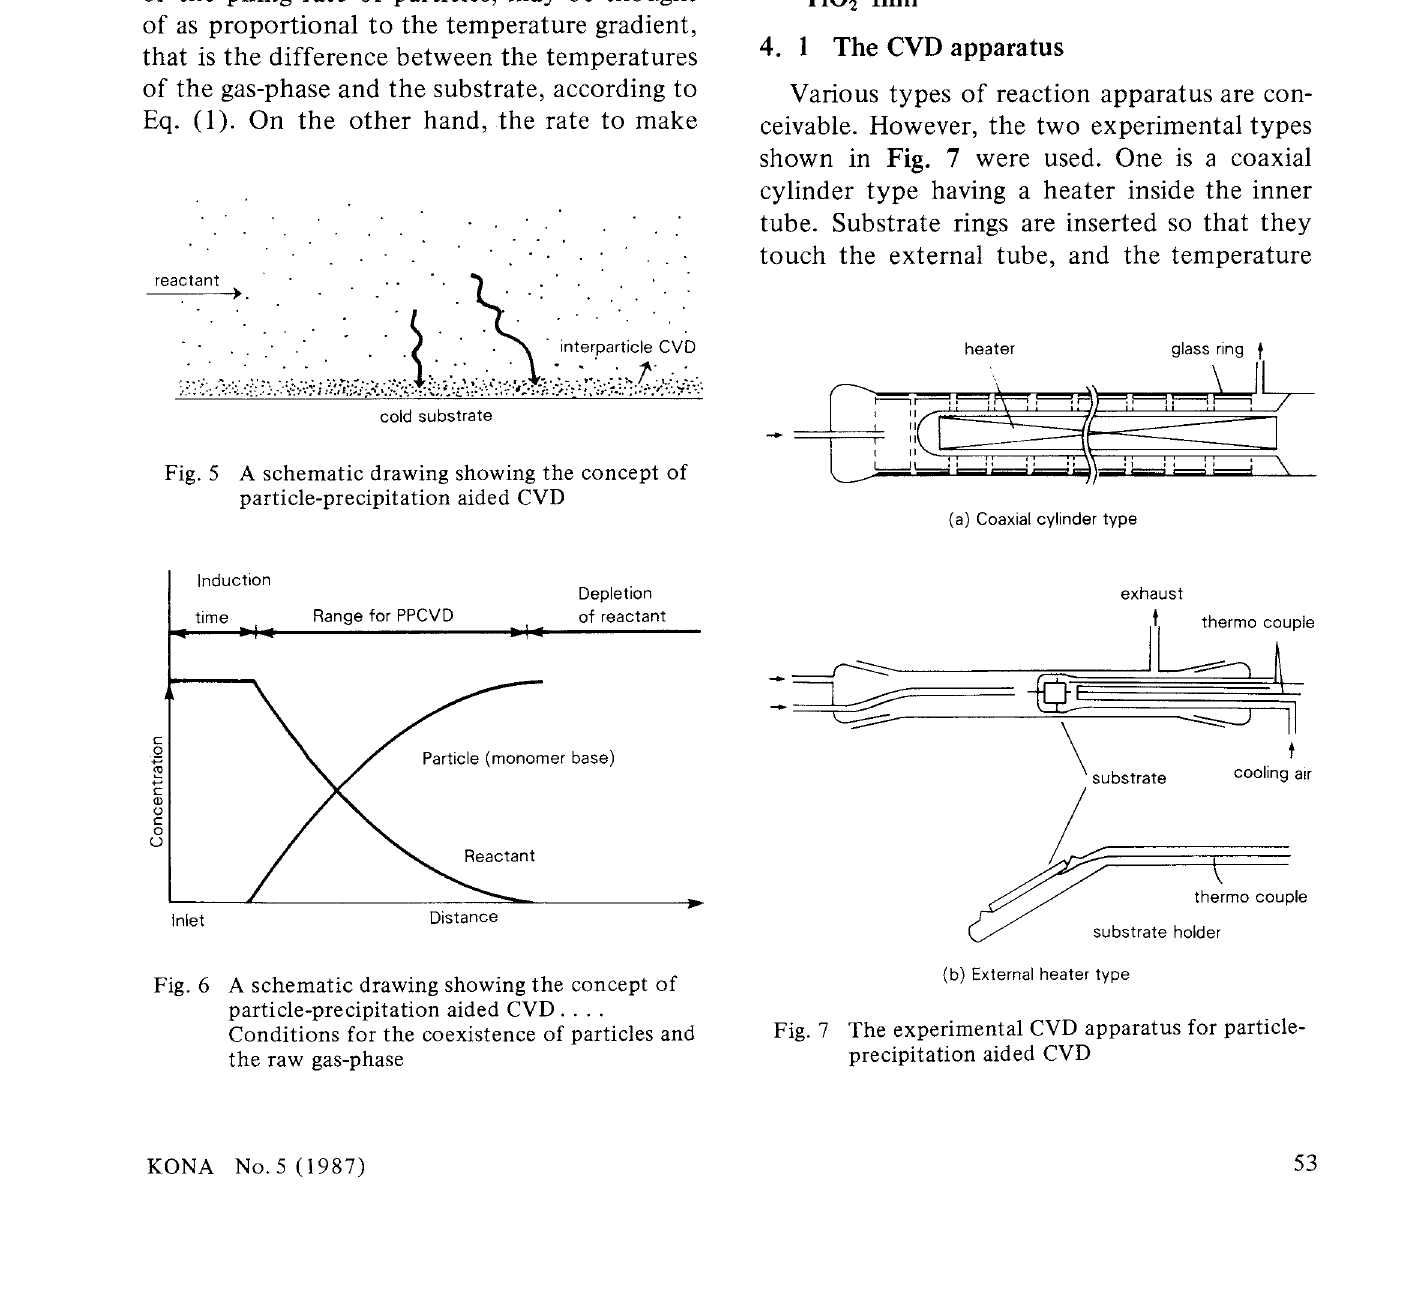
Fig. 7 The experimental CVD apparatus for particle precipitation aided